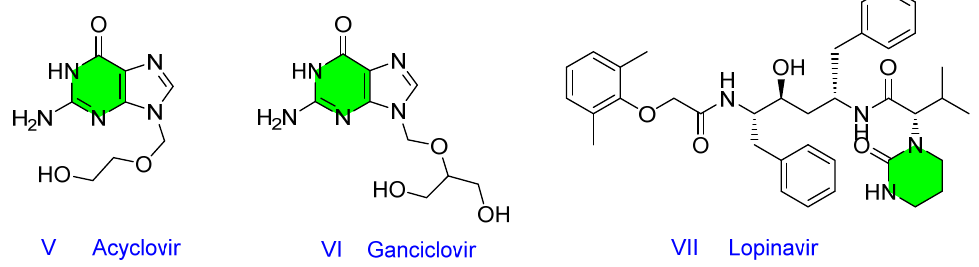
Figure 2. Antiviral drugs having pyrimidine